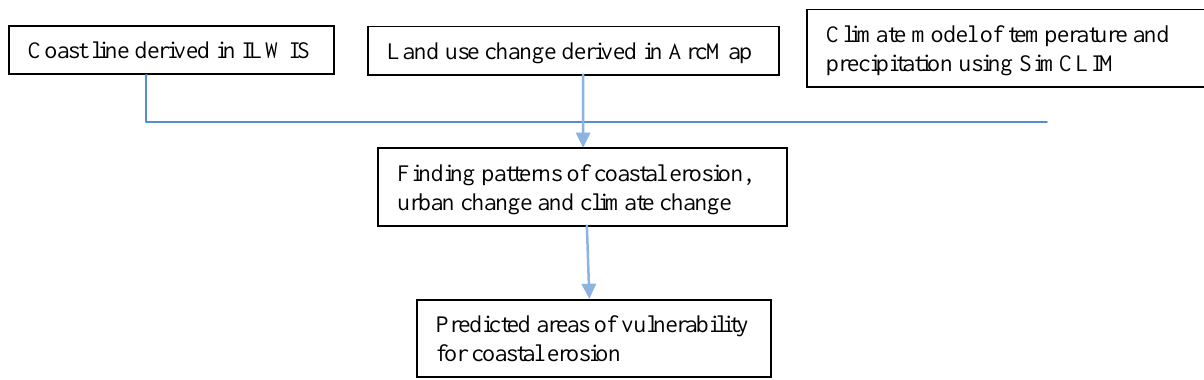
Figure 2. Combined